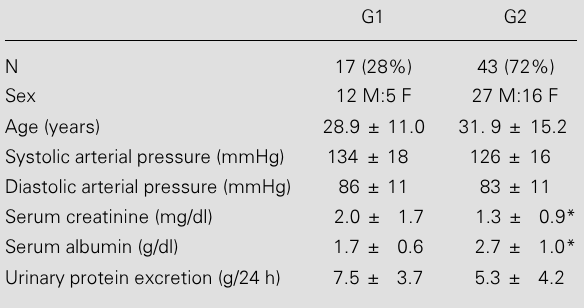
Table 1 - Clinical characteristics of the patients with (G1) and without (G2) glycosuria. Data are reported as mean – SD. *P<0.05, G1 vs G2 (Student t -test).